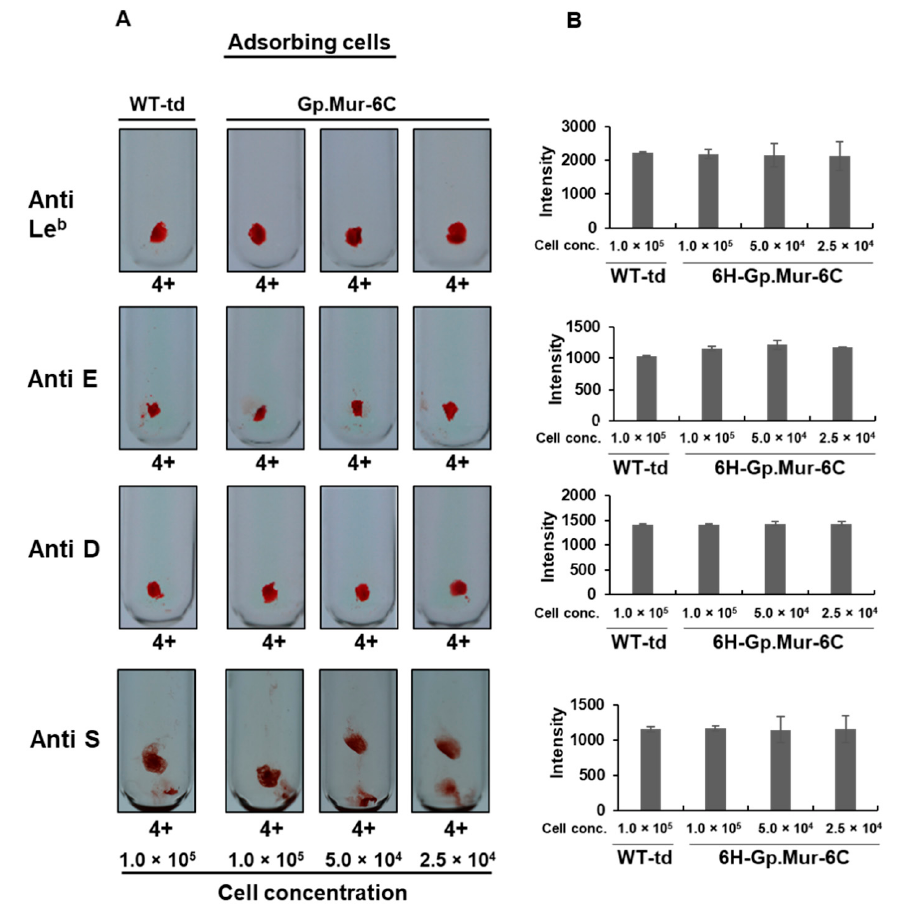
Figure 5. Hemagglutination inhibition by noncorresponding antibodies. Hemagglutination inhibition was performed on several antibodies not corresponding to Gp.Mur antigen, i.e., anti-Le b , anti-E, anti-D, and anti-S. ( A ) Visual grading from the conventional tube method. ( B ) Densitometric-based quantification of hemagglutination. On the X axis are the cell concentrations (cell conc.) of the adsorbing cells (WT-td or 6H-Gp.Mur-6C) and on the Y axis are the signal intensities of the RBC agglutinates.